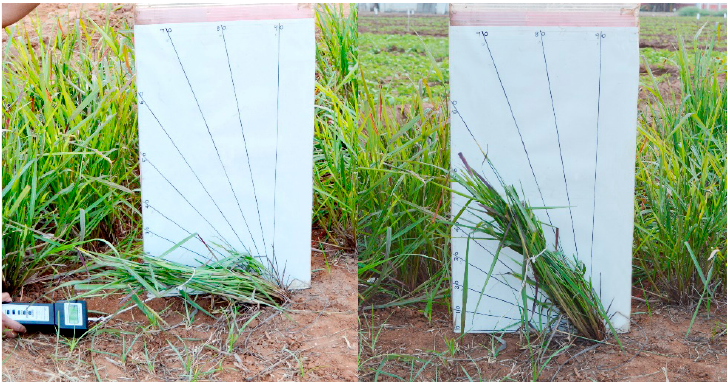
Figure 2. Push-pull gauge used to measure the culm strength in the mutant population.